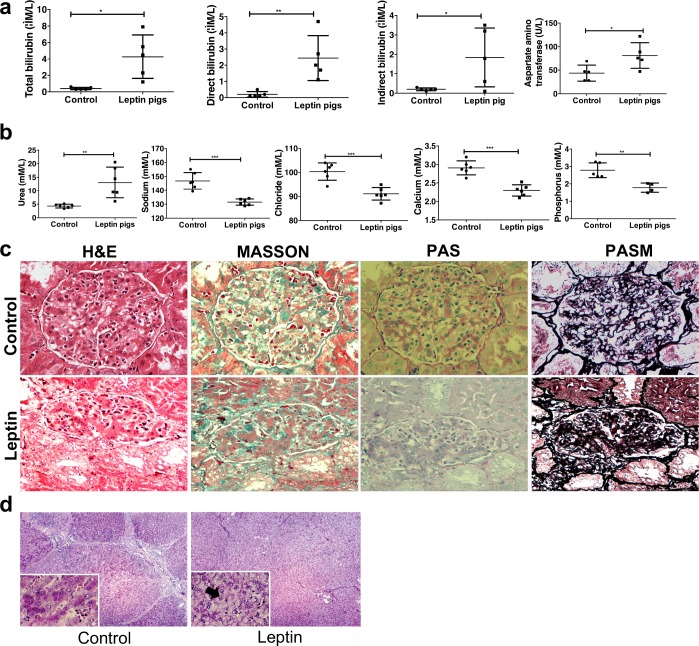
Pathological changes of renal or hepatic cells in transgenic leptin pigs.(a) Routine markers that reflect liver and kidney physiological functions. Aspartate amino transferase concentration was elevated in leptin-overexpressing pigs (n = 6 per group). (b) Examination of the levels of several ions in the peripheral blood of leptin-overexpressing pigs. Blood urea concentration was elevated in leptin-overexpressing pigs (n = 6 per group). (c) Serial sections of kidney tissues analyzed by H&E/Masson/PAS/PASM indicate the presence of renal injury in leptin-overexpressing pigs. Original magnification, 400×. (d) H&E staining indicates hepatocellular balloon changes in the hepatocytes of leptin-overexpressing pigs. Original magnification, 100×. *p < 0.05, *p < 0.01, ***p < 0.001, two-tailed Student t test for a,b. Data are presented as mean ± SEM. Numerical values are provided in S1 Data. H&E, hematoxylin and eosin; PAS, Periodic Acid–Schiff; PASM, Periodic Acid–Silver Methenamine.